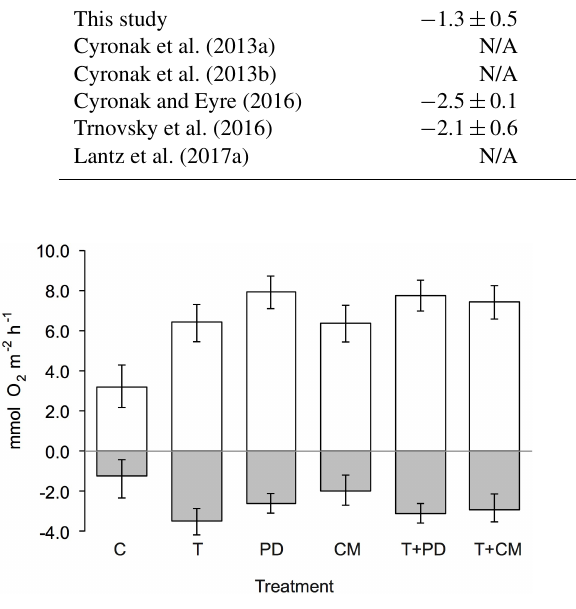
Figure 5. Mean sediment gross primary production (GPP: mmolO 2 m − 2 h − 1 ) and respiration ( R : mmolO 2 m − 2 h − 1 ) in re- sponse to warming ( + 2.4 ◦ C) and each OM treatment (phytodetri- tus and coral mucus). Control ( C ; n = 9) and warming ( T ; n = 7) treatments are averaged over all four incubations and the replicate chambers therein. Phytodetritus (PD), coral mucus (CM), and com- bination ( T + PD, T + CM) treatments are averaged over the two incubations (and replicate chambers therein) in which each respec- tive OM treatment was used ( n = 4). Average measured rates ± SD are represented in white for GPP (positive) and grey for R (nega- tive).